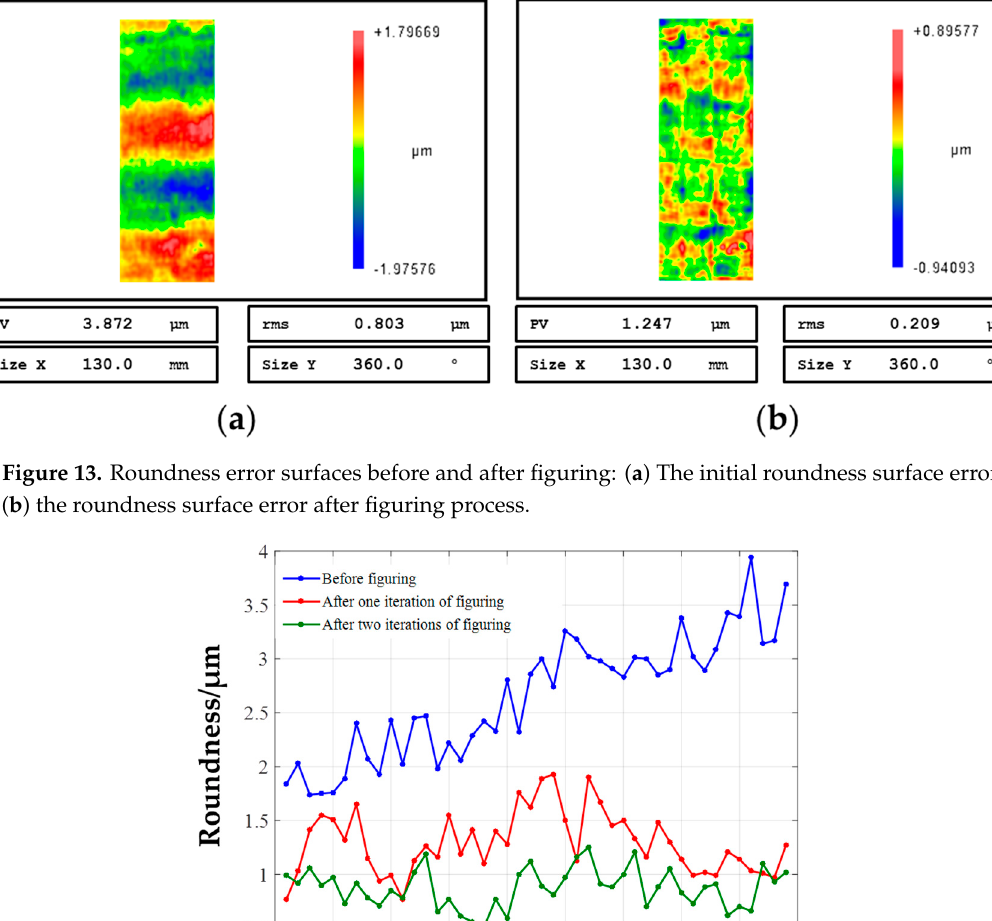
Figure 13. Roundness error surfaces before and after figuring: ( a ) The initial roundness surface error; ( b ) the roundness surface error after figuring process.